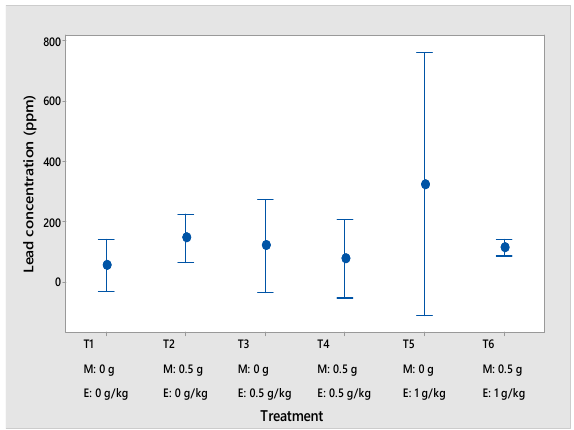
Figure 5. Lead concentrations in the roots of the treated plants